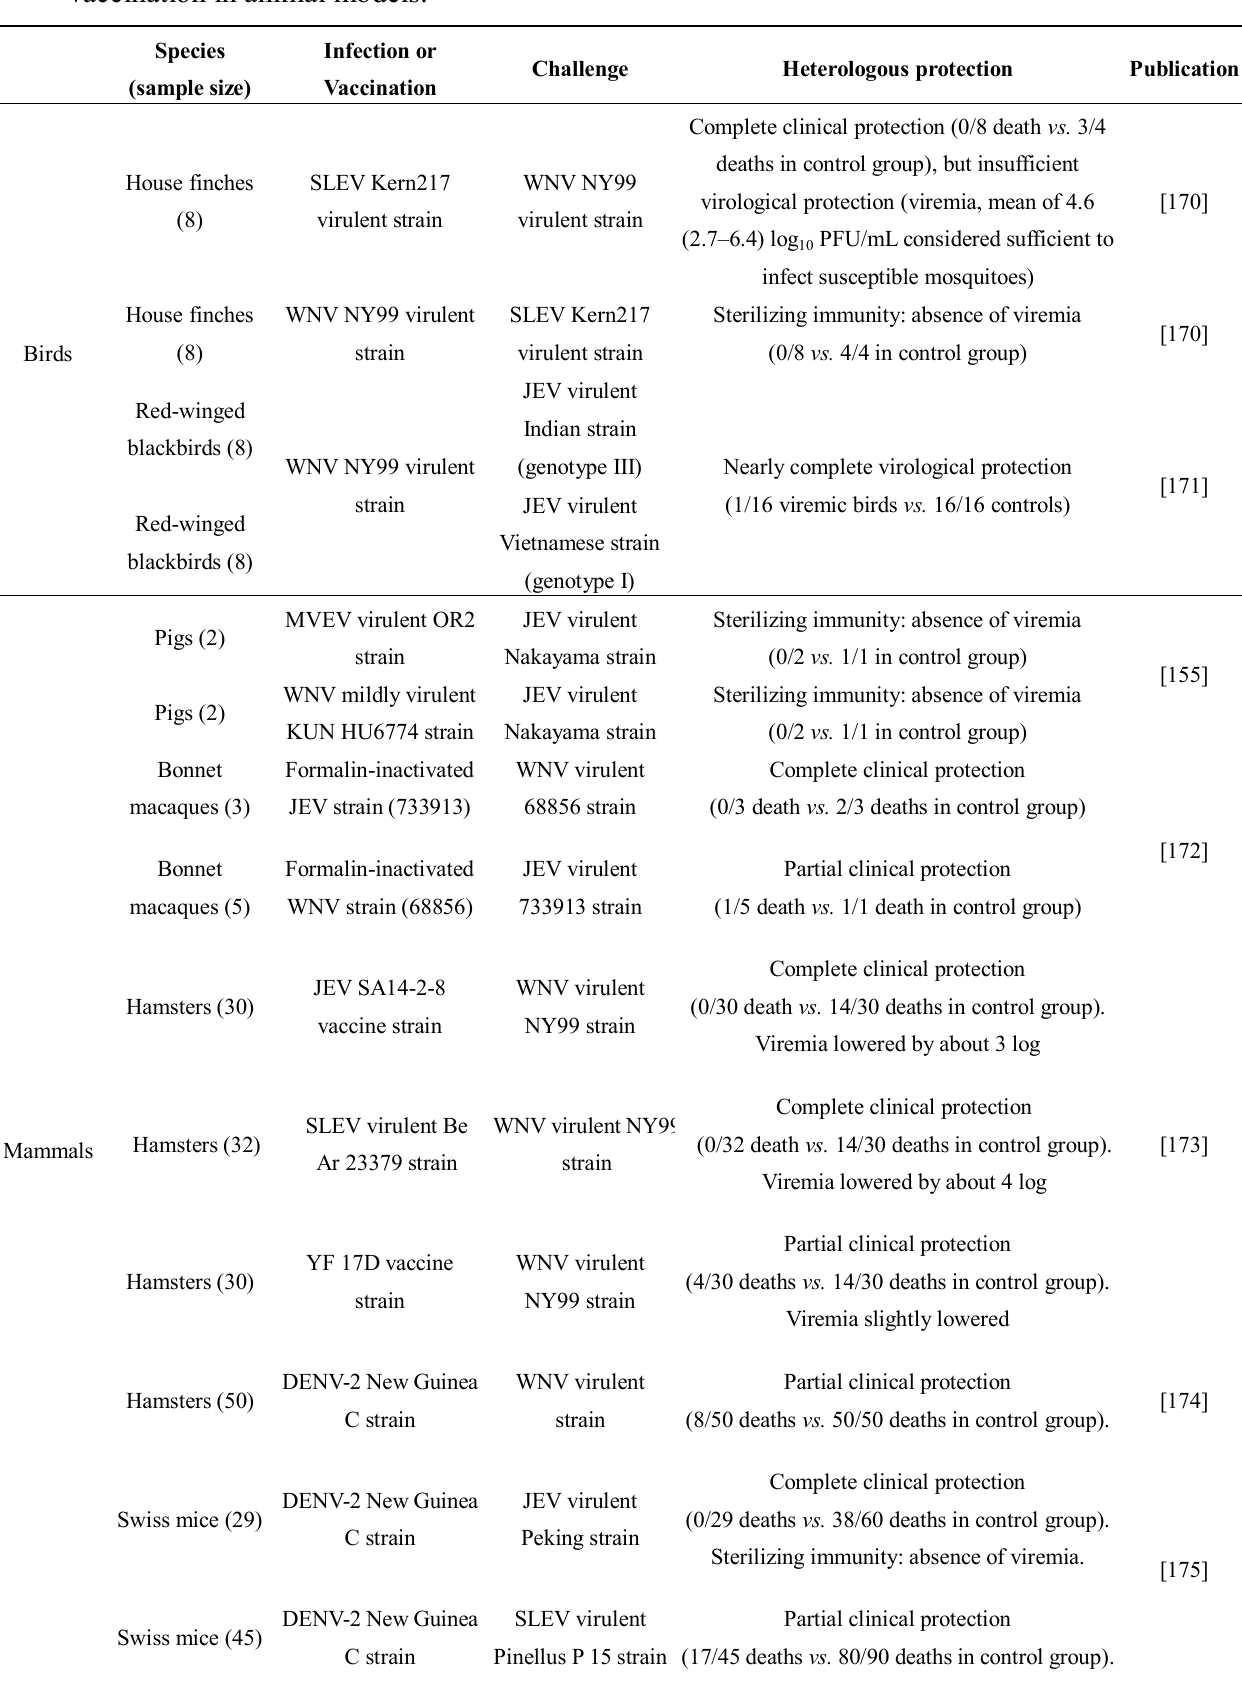
Table 2. Assessment of the heterologous protection afforded by prior flavivirus infection or vaccination in animal